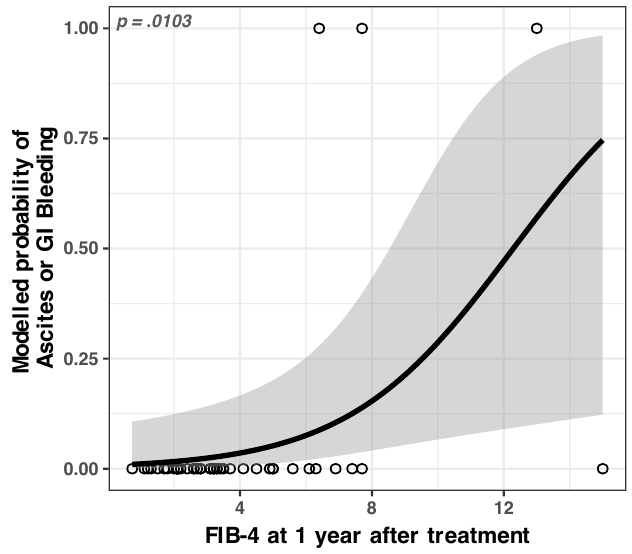
Figure 6. Modelled odds ratio (OR) of developing vs. not developing ascites/GI bleeding as a function of FIB-4 after 1 year of treatment. The grey bands represent the 95% confidence interval; see Table A5 for the full numerical